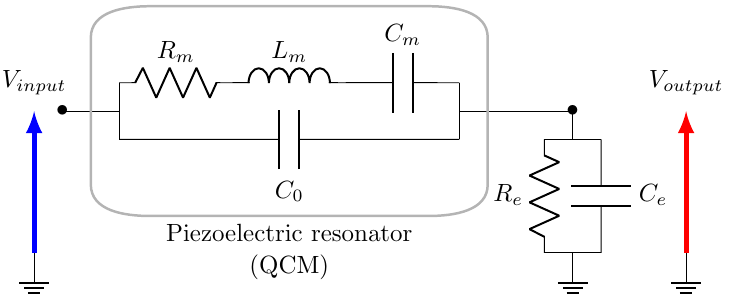
Figure 4. Low pass quartz cristal microbalance (QCM)-based resonant filter